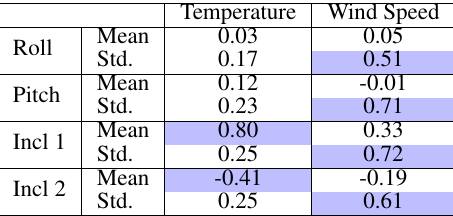
Table 4. Pearson correlation coefficients of mean values and standard deviations of pitch and roll with temperature and wind speed respectively. The significant correlation values are marked in